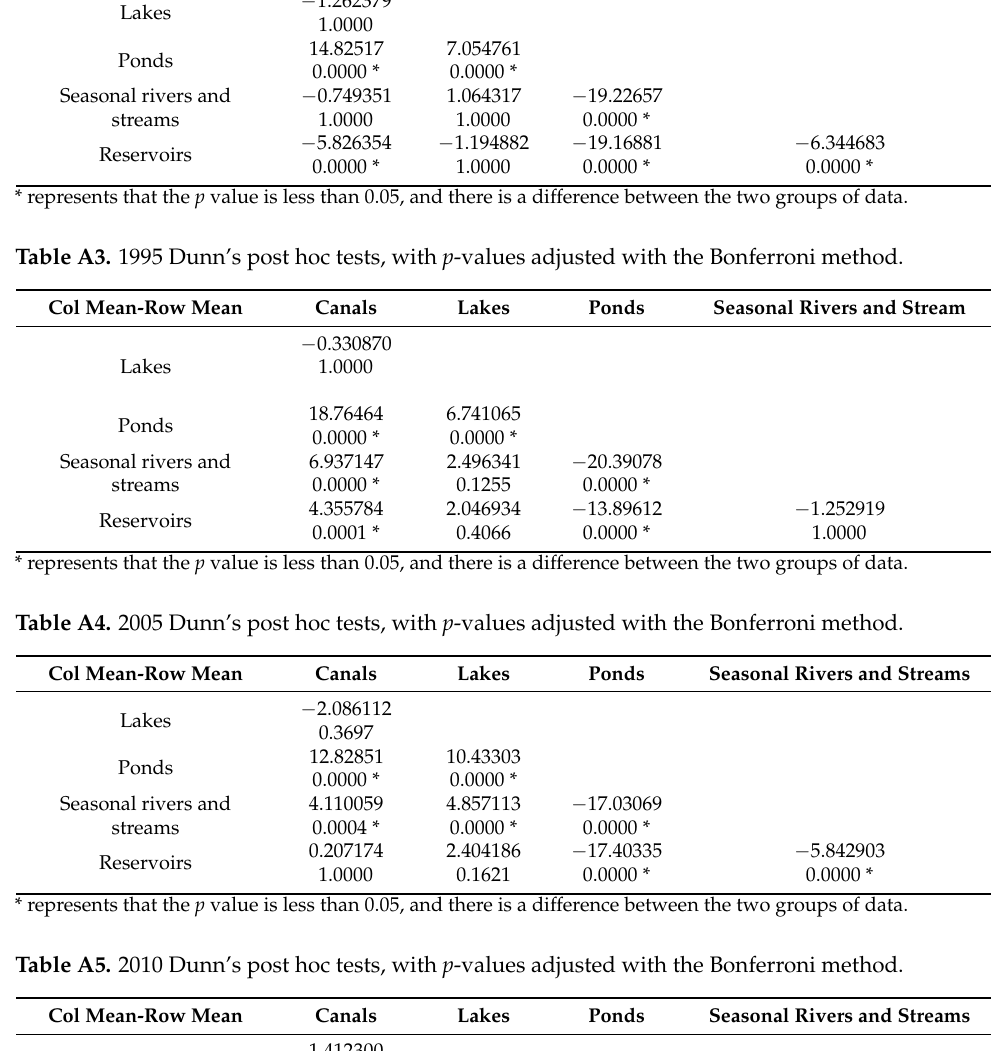
Table A2. 1990 Dunn’s post hoc tests, with p -values adjusted with the Bonferroni method. Col Mean-Row Mean